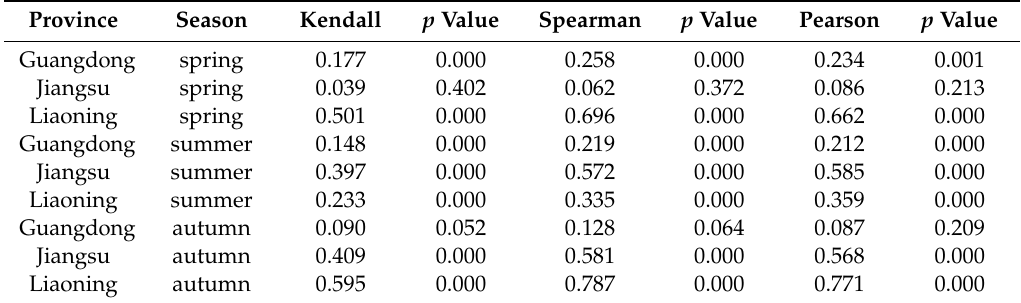
Table 3. Correlation coe ffi cients of Tmin–NDVI in spring, summer and autumn in Guangdong, Jiangsu and Liaoning.